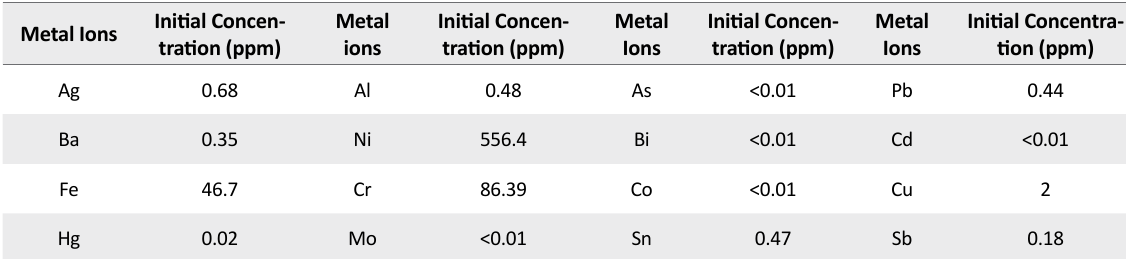
Table 1. The initial concentration of metal ions at a temperature of 25±1 °C Metal